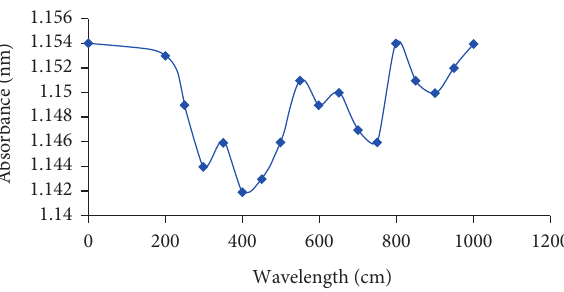
Figure 3: Absorbance and wavelength variation for the lateritic soil using an ultraviolet-visible spectrophotometer at 25 ° C.